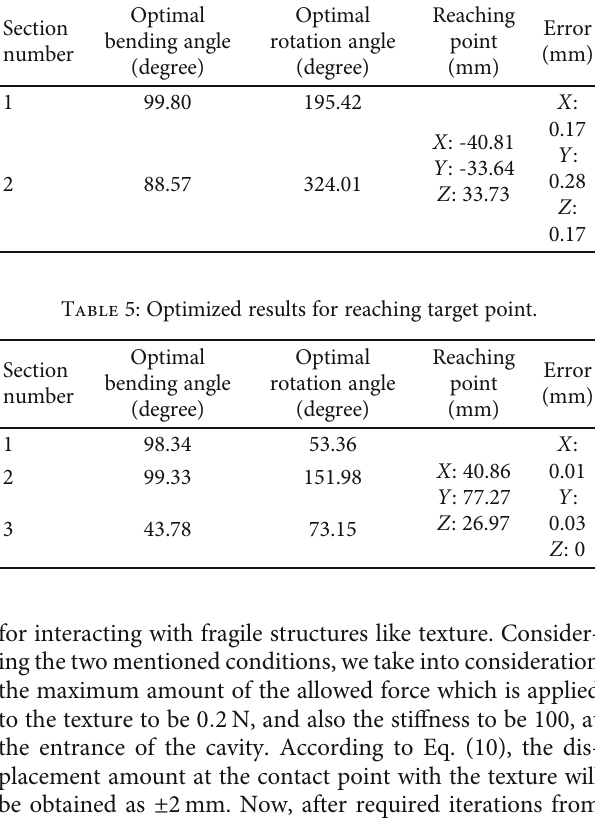
Figure 15: Genetic algorithm for best fi tness target point in three-segment catheter. Table 4: Optimized results for reaching target point. Table 6: Optimized results for three-segment catheter with variable length.